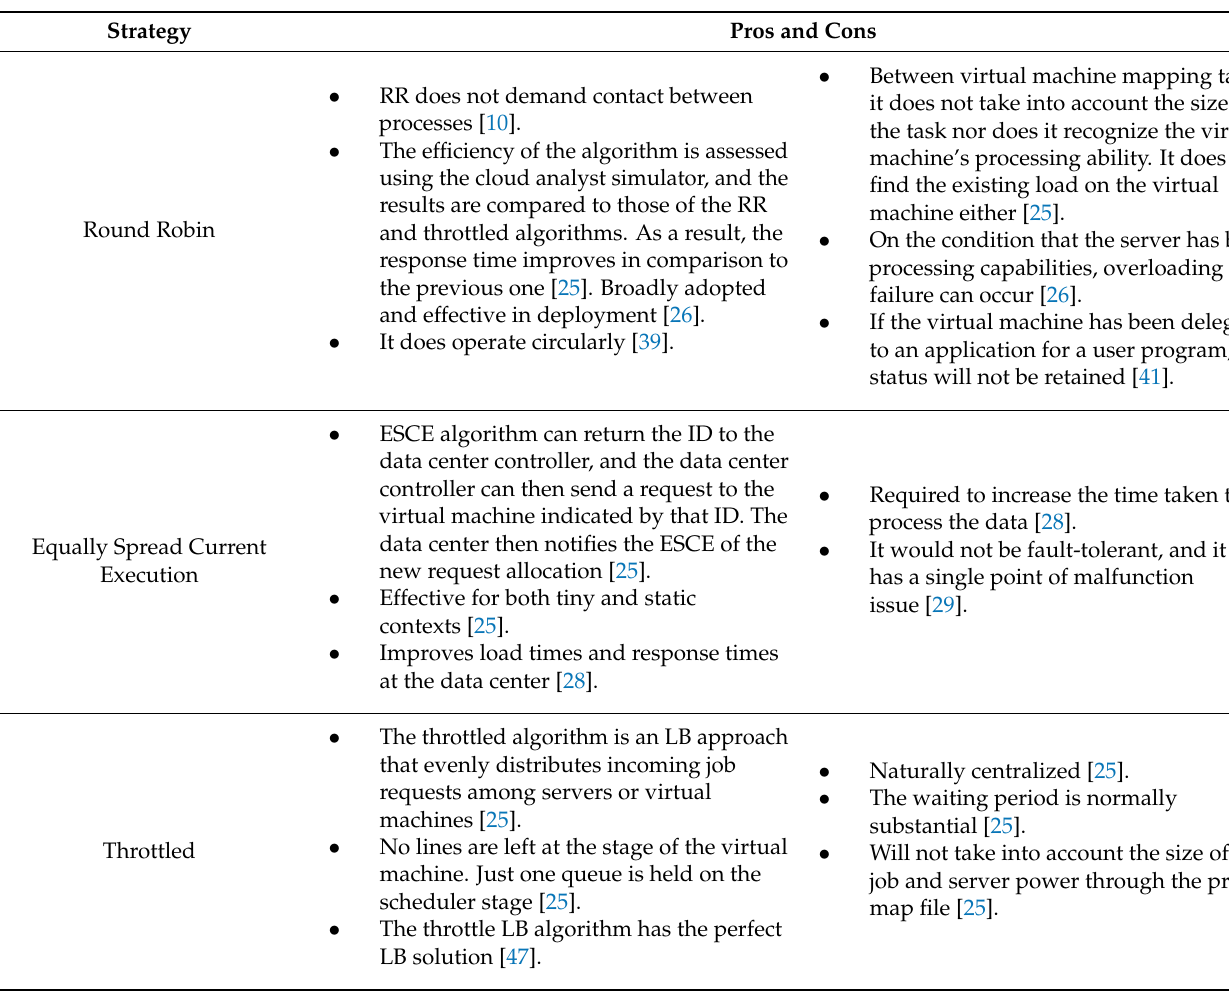
Table 2. Pros and cons of the load-balancing algorithm.